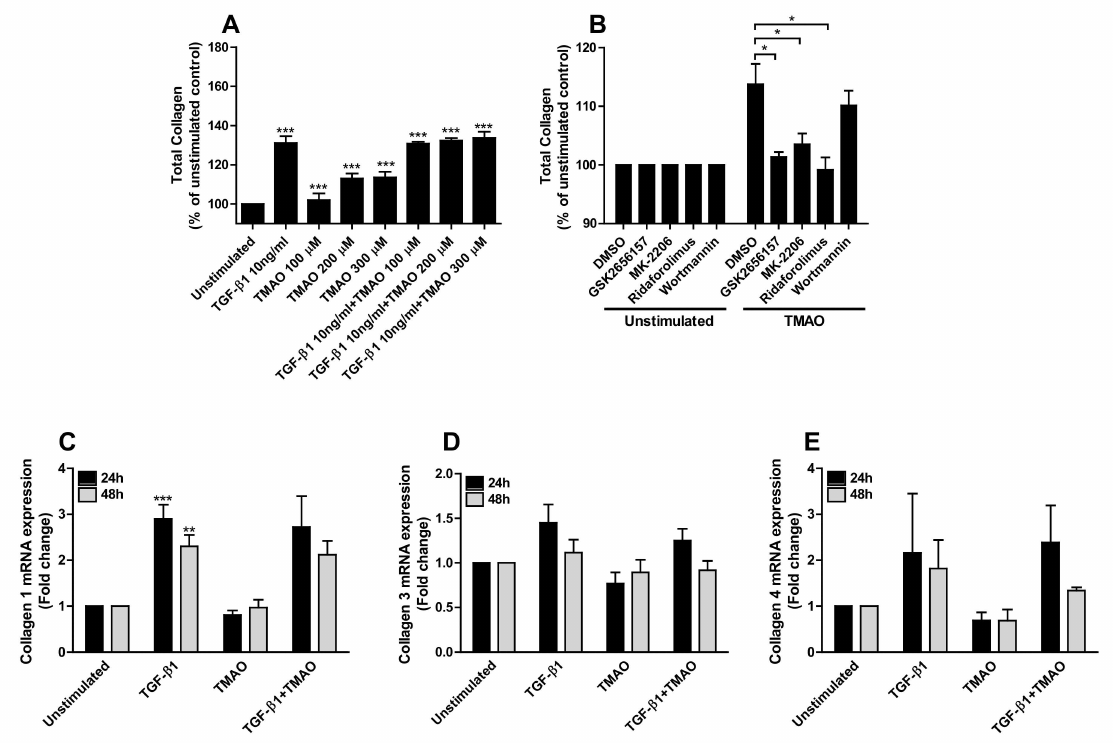
Figure 6. TMAO increases total collagen production from renal fibroblasts through the PERK/Akt/mTOR pathway. Renal fibroblasts were stimulated with 100–300 µ M TMAO and 10 ng/mL TGF- β 1 for 96 h and total collagen production was evaluated ( A ). Renal fibroblasts were also pre-incubated with DMSO (vehicle), PERK inhibitor GSK2656157 (0.5 µ M), Akt inhibitor MK-2206 (1 µ M), mTOR inhibitor ridaforolimus (1 µ M) or PI3K inhibitor wortmannin (1 µ M) for 1 h prior to TMAO stimulation (300 µ M) for 96 h ( B ) followed by evaluating total collagen production. Total collagen is presented as % of unstimulated control. Real-time RT-PCR was conducted to detect mRNA expression of collagen 1 ( C ), 3 ( D ), and 4 ( E ) following TMAO (300 µ M) and TGF- β 1 10 ng/mL stimulation for 24–48 h. Data are presented as mean ± SEM ( n = 3 independent experiments). Asterisks denote statistical significance compared to unstimulated cells (* p < 0.05, ** p < 0.01, *** p <